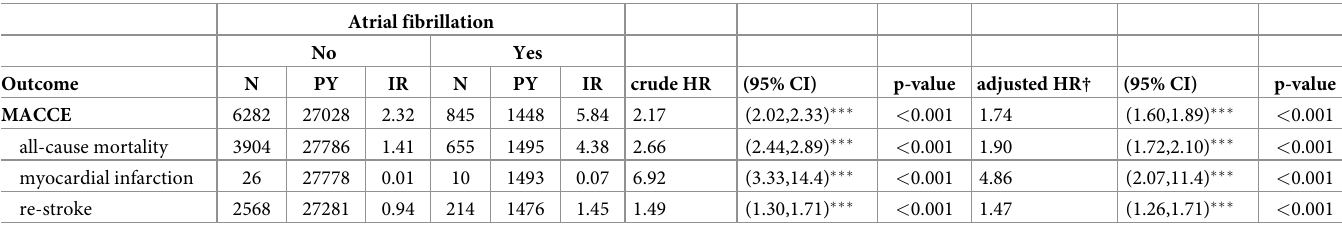
Table 3. The association of atrial fibrillation and 1 year outcomes.